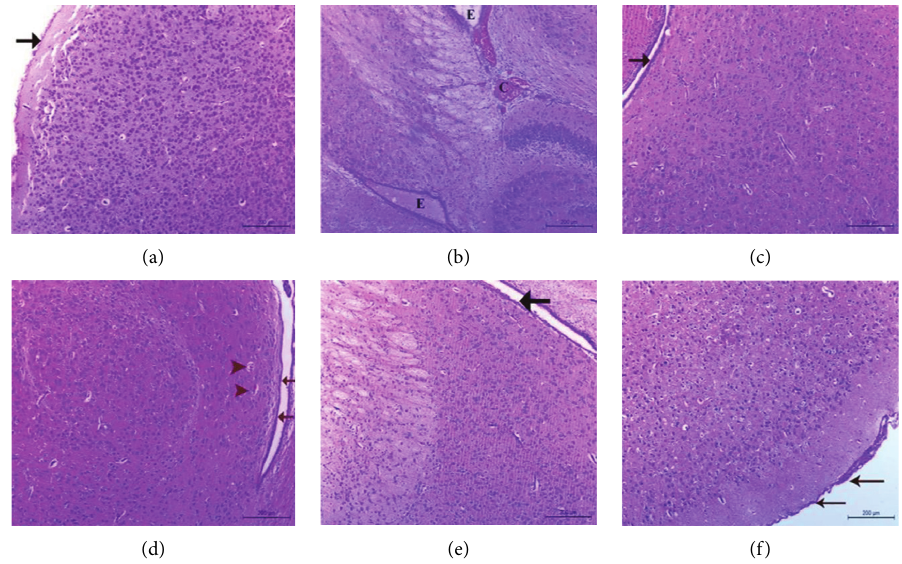
Figure 3: A photomicrograph of brain tissue in adult male albino rats showing the groups. (a) Control group, the brain tissue was covered by well-demarcated normal fine fibrous meninges (arrow). The brain tissue appeared normal in constituent with normal nerve cells and glial tissue. The meningeal and cerebral blood vessels appeared normal. (b) N group, the brain tissue covered with meninges suffered from thickening, congestion of meningeal blood vessels (C), and submeningeal edema (E). Both nerve cells and glial tissue showed degenerative changes. (c) NNG group, the brain tissue, and the meningeal layers (arrow) appeared normal. (d) N +E group, the brain tissue, and meninges (arrow) appeared normal. The cortical blood vessels suffered from congestion (arrow head). (e) N +NNG group, the brain tissue covered with normal meninges (arrow). The nerve cells and glial tissue appeared normal. (f) N +NNG +E group, the meningeal layers (arrow), and the brain tissue appeared normal. H&E stain X 100.